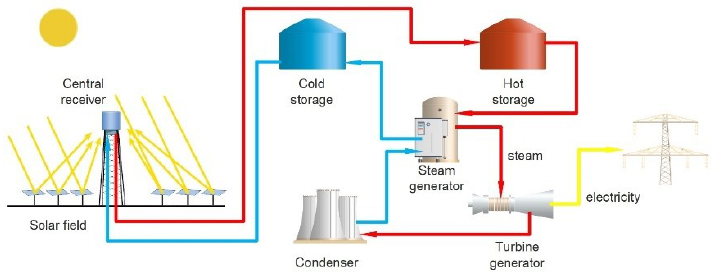
Figure 2. Schematic of a tower CSP generation system.